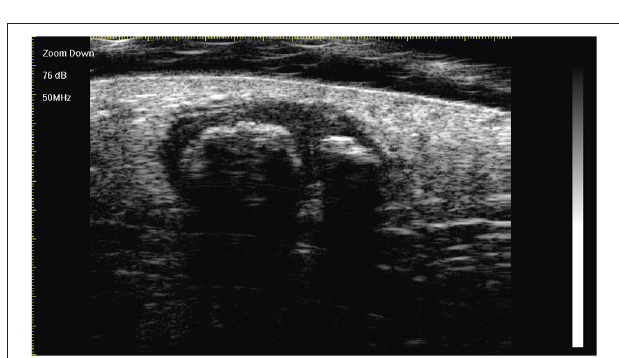
FIGURE 2 | The lesion is a heterogeneous, well-demarcated, hypoechoic tumour located between the deep dermis and the subcutis with typical ultra-high-frequency ultrasonographic features, including internal echogenic foci, hypoechoic rim, and posterior acoustic